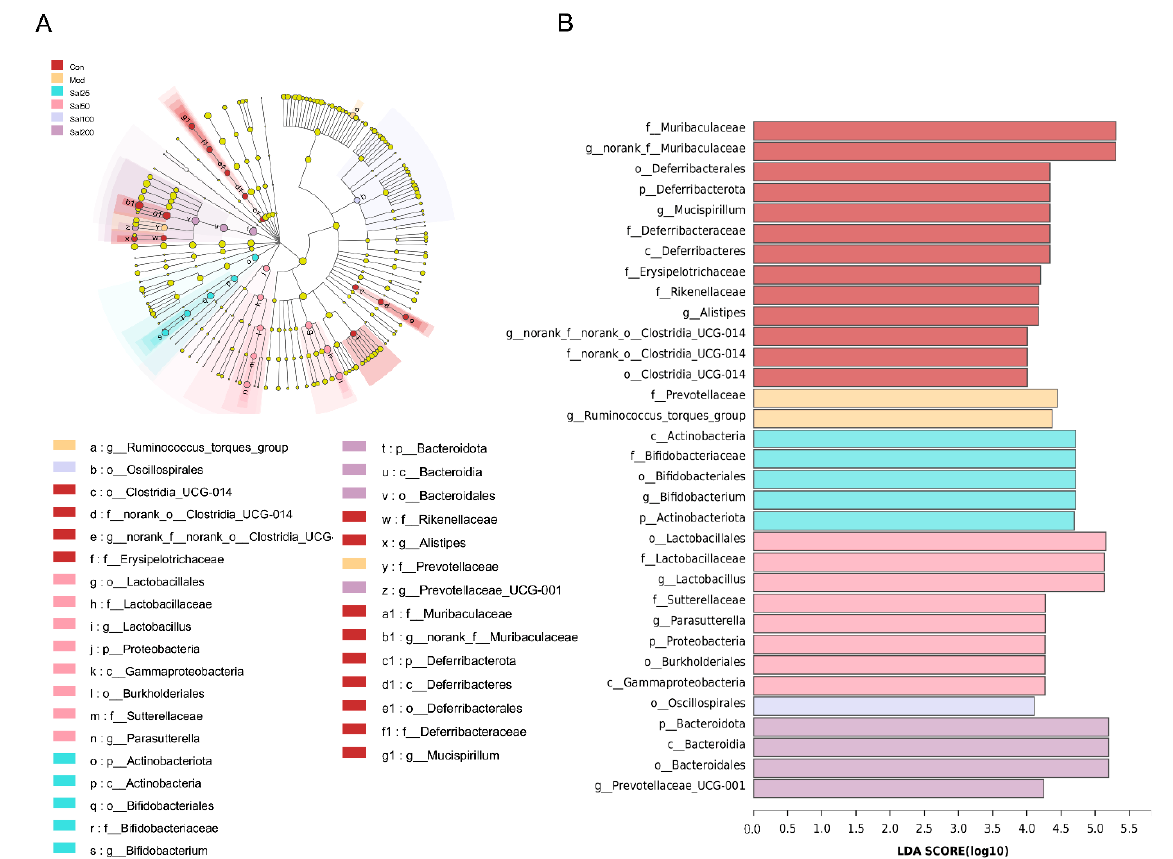
Figure 6. An linear discriminant analysis (LDA) effect size (LEfSe) analysis and LDA score for taxa differing between six groups. ( A ) The taxonomic cladogram obtained from the LEfSe analysis of gut microbiota. ( B ) The LDA score obtained from LEfSe analysis of gut microbiota in different groups. LDA score was set at 4.